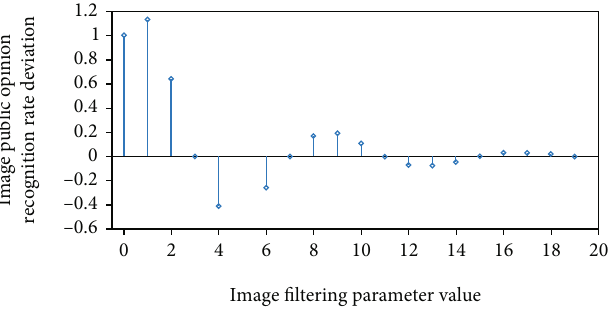
Figure 8: Image public opinion feature information recognition deviation matchstick diagram.